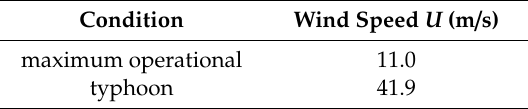
Table 7. Wind speed conditions in the full